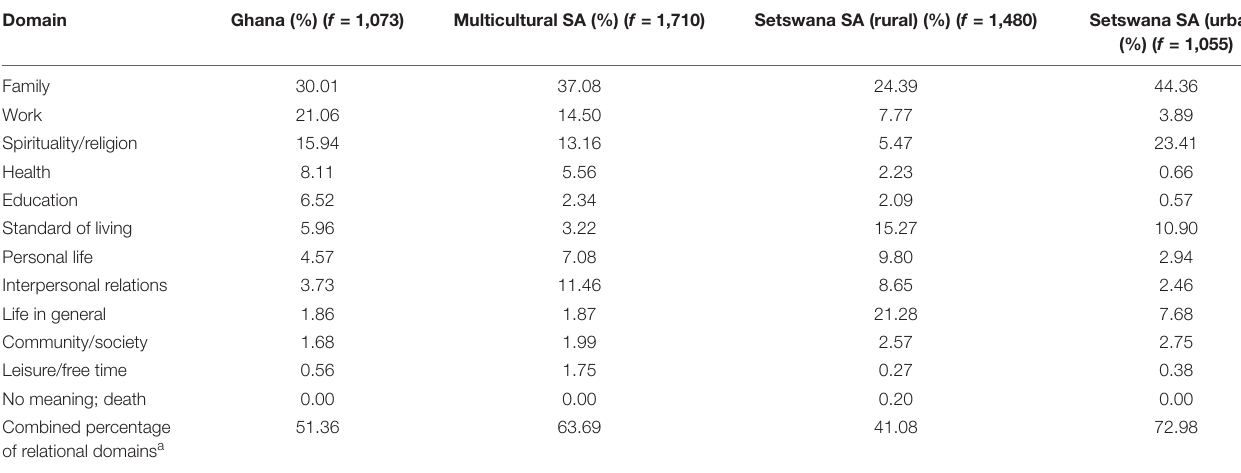
TABLE 2 | Percentages of life domains as meaning